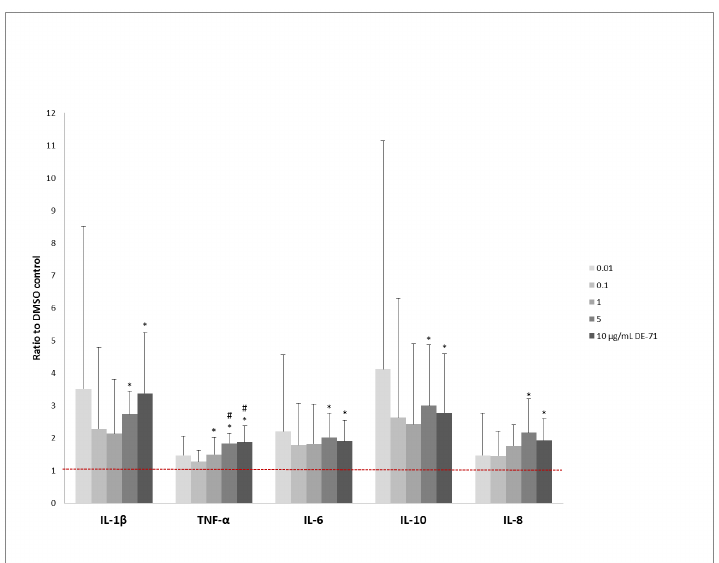
Fig 1. Influence of DE-71 on cytokine responses of PBMCs. Mean + SD of secretion of IL-1 β , IL-10, TNF- α , IL-8, and IL-6 from DE-71 exposed and LPS-stimulated PBMCs are shown as ratios to the respective DMSO controls. The red dotted line indicates the level of the DMSO controls (ratio = 1). * = p < 0.05 compared to DMSO control, # = p < 0.05 compared to 0.1 μ g/mL DE-71. PBMC: peripheral mononuclear cells, LPS: lipopolysaccharide, IL-1 β : interleukin-1 β , IL-10: interleukin-10, TNF- α : tumor necrosis factor- α , IL-8: interleukin-8, IL-6: interleukin-6, DMSO = dimethyl sulfoxide, SD = standard deviation.